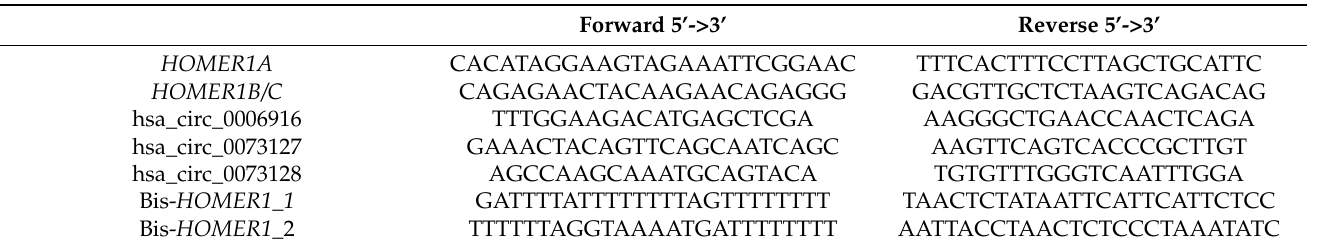
Figure 1. HOMER1 and circHOMER1 variants expression. ( A ) Gen map for each linear and circular HOMER1 RNA form. Boxes represent exons and arrows show where primers are located. ( B , C ) Box-plot represents the percentage of HOMER1 and circHOMER1 expression relative to geometric mean of GAPDH and ACTB housekeeping genes expression in females ( n = 23) and males ( n = 21). * p -value< 0.05; ** p -value < 0.01; **** - value < 0.0001. Table 1. Primers